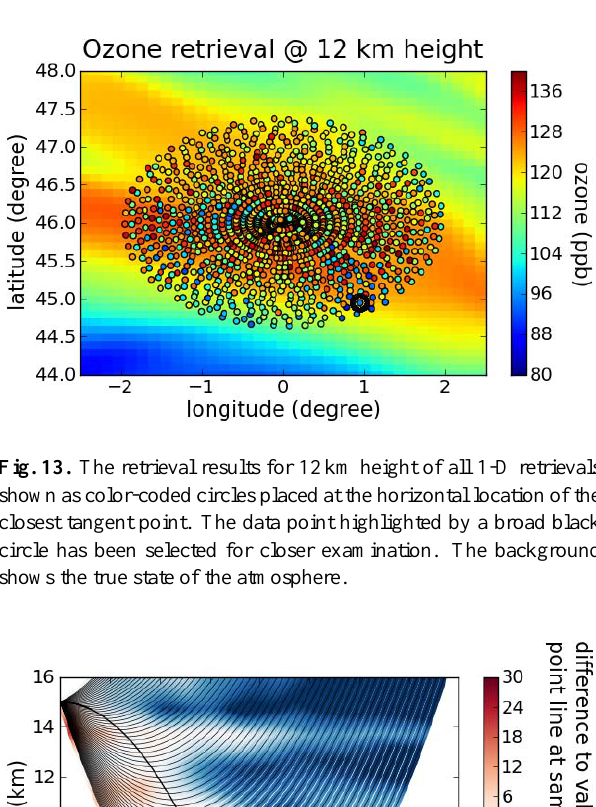
Fig. 12. This figure demonstrates an octagonal flight path. (a) Shows the location of the tangents of the measurements as color- coded spheres (red being the first measurements, blue the last ones) and the flight-track as white tube. (b) Shows the relative error of the retrieval result at 12km height.